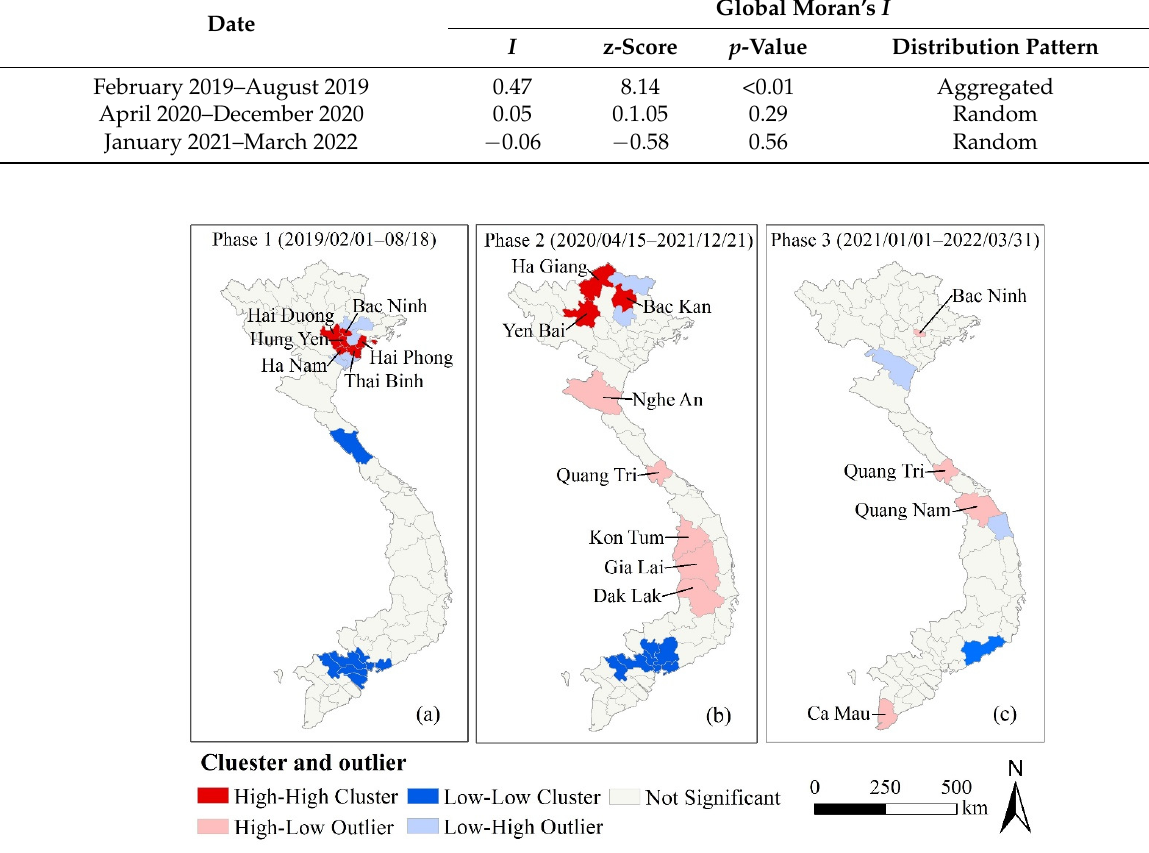
Figure 4. Maps of clusters and outliers of the ASF occurrence rate in Vietnam (February 2019–March 2022).